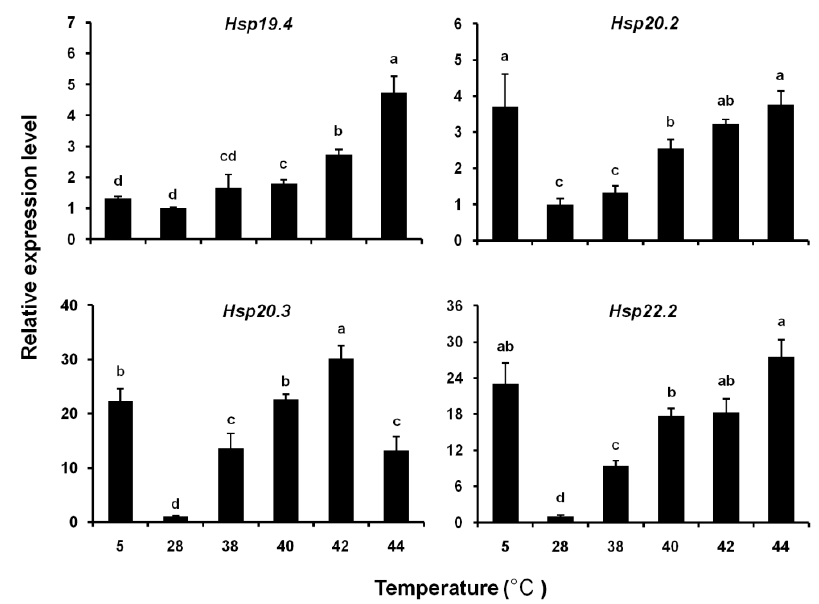
Figure 6. Relative expression levels of four LsHsp genes in L. serricorne in response to thermal stress. Different letters above bars indicate a significant difference based on one-way ANOVA followed by a least significant difference test ( p < 0.05).